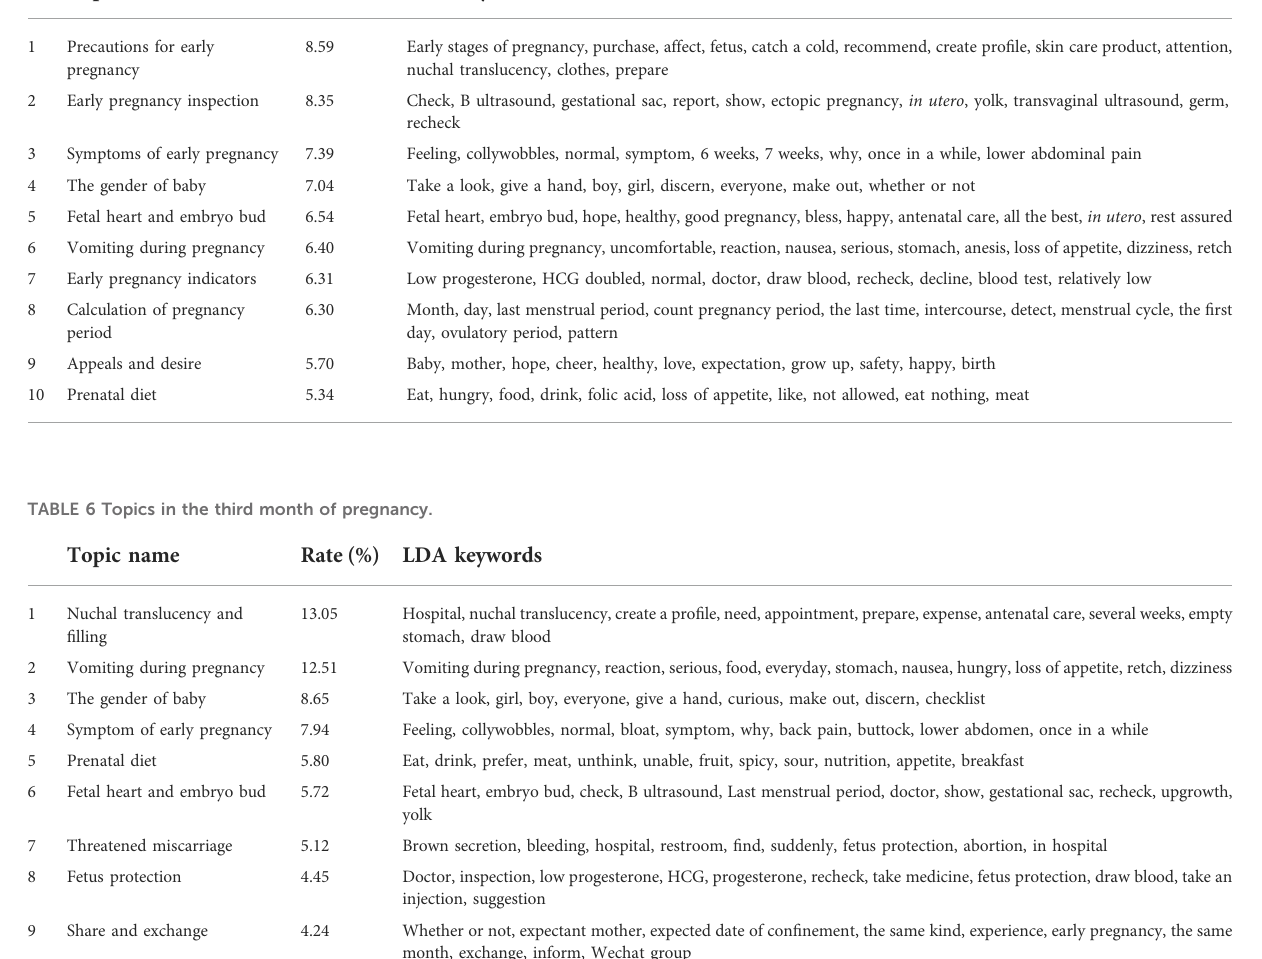
pregnancy reaction, ” accounting for 16.59%, 14.73%, and 14.02%, respectively, were the second, third, and fourth most frequent topics. Among them, early pregnancy reaction refers to